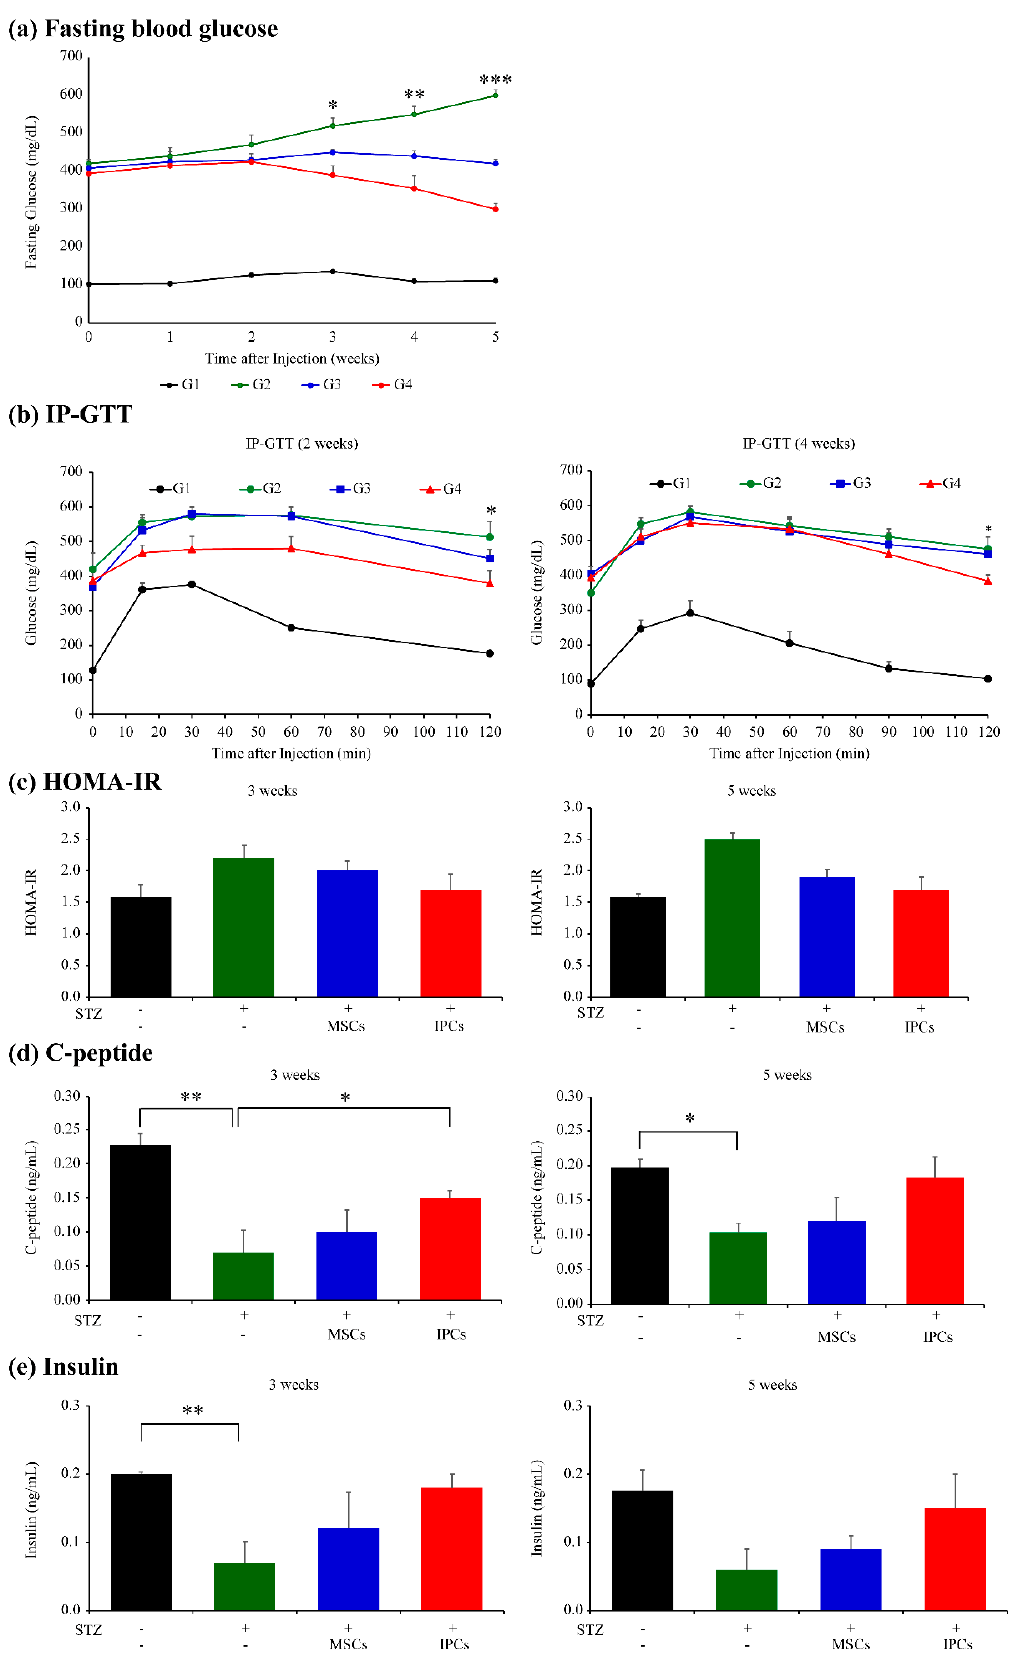
Figure 6. Functional analysis after hUC-MSC and hUC-IPC transplantation in vivo. ( a ) Blood glucose levels after hUC-MSCs and hUC-IPCs transplantation. Glucose levels were monitored using